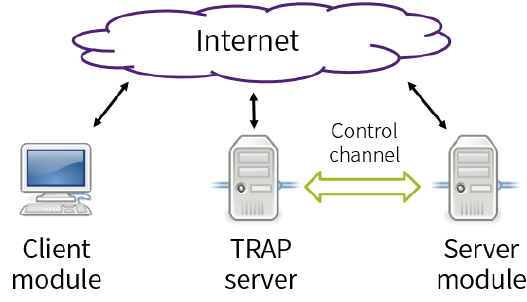
Figure 7. System design.